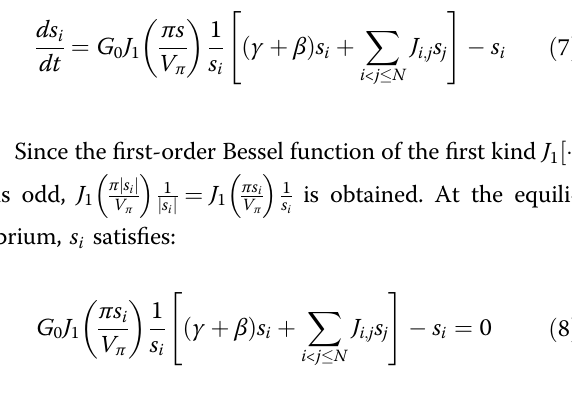
netic fi eld. As N and ξ are both constants, the signal decay (11) conforms to the physical intuition about an oscillator. Assuming each spin has a normalized loss of one in an N-spin oscillation network, the global signal decay rate is N if there is no interaction between those spins. If the i- th spin is injected by the j- th spin with the coupling coef fi cient of J the signal decay rate of the i- th spin would rise (if J σ σ or fall (if J > 0) by |J | . Since all the couplings from i,j i j i,j